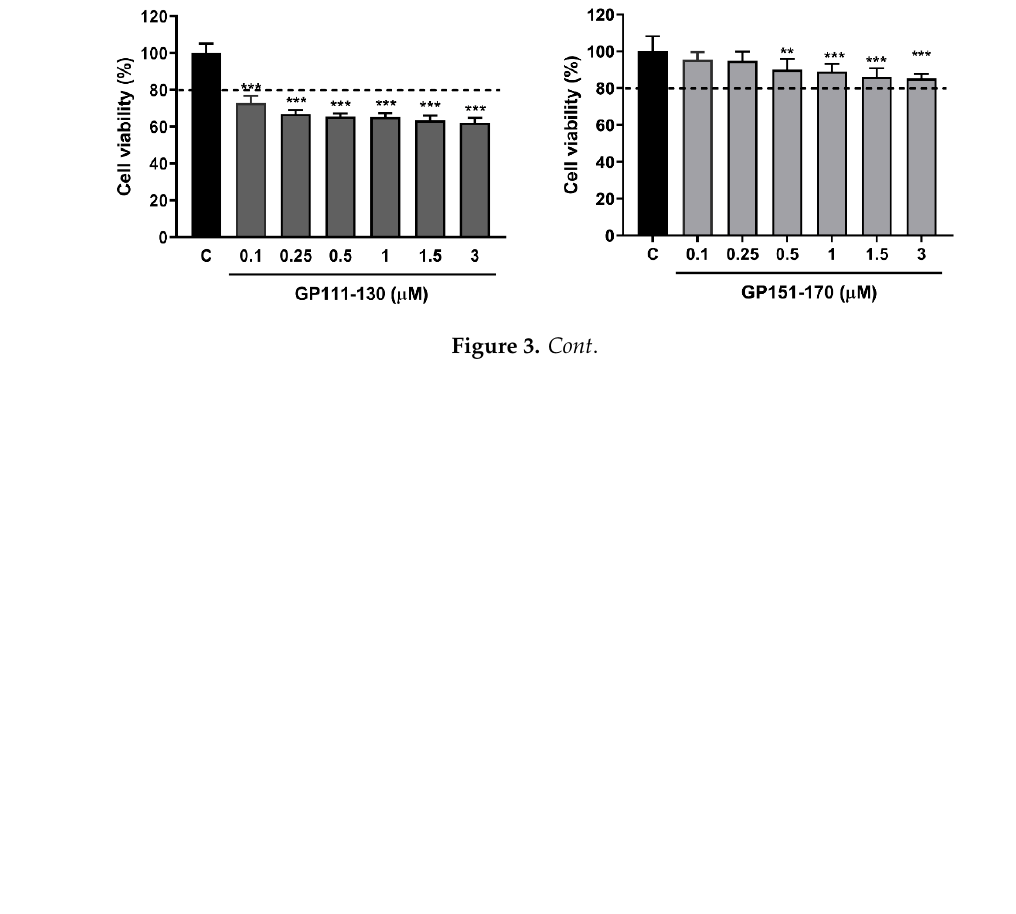
Figure 2. Effects of treatment with synthetic gliadin peptides or wheat gluten hydrolysate (WGH) on reactive oxygen species (ROS) production in adult-stage C. elegans worms. ( A ) Schematic of α -gliadin motifs with respective peptide sequences. Three kinds of synthetic α -gliadin peptides were generated that either possess cytotoxic activity (red) or gut-permeating activity (green or blue) as previously reported [7]. ( B,C ) Wild-type N2 animal populations synchronized at the L4 larval stage were treated with synthetic gliadin peptides and ROS production was measured by 2 ′ ,7 ′ - dichlorodihydrofluorescein diacetate (DCFDA) staining 24 h after treatment. Pictures show representative images of DCFDA staining indicating ROS production after treatment ( B ). Bar graph ( C ) shows the pixel intensities from DCFDA fluorescence per worm. Error bars represent s.d.; n.s., not significant; ** p < 0.005 (Student’s t -test). ( D,E ) Wild-type N2 animal populations synchronized at the L4 larval stage were treated with WGH and ROS production measured by DCFDA staining after 24 h of treatment. Pictures show representative images by DCFDA staining indicating ROS production after treatment ( D ). Bar graph ( E ) shows the pixel intensities from DCFDA fluorescence per worm. Error bars represent s.d. n.s., not significant. (Student’s t -test).